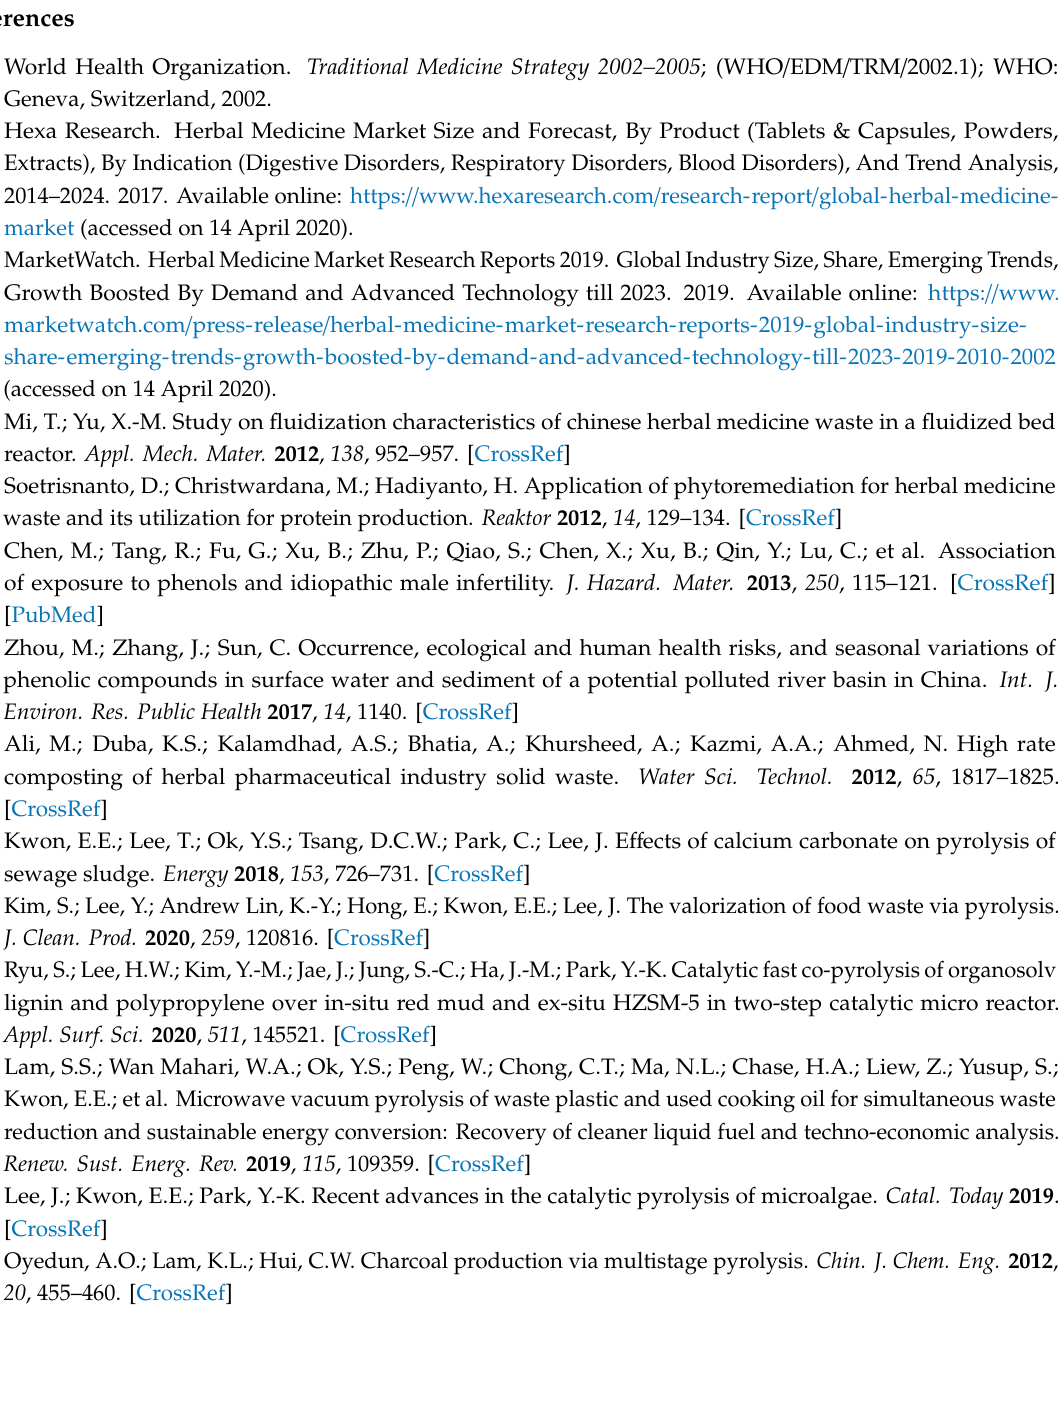
Figure S1: (a) Representative TEM image of the Pt / AC catalyst; and (b) particle size distribution of the Pt / AC catalyst, Figure S2: Schematic of the pyrolysis reactor setup used in this study, Figure S3: Composition of pyrolytic gas (including CO 2 ) evolved from the non-catalytic and catalytic N 2 pyrolysis of the herbal medicine